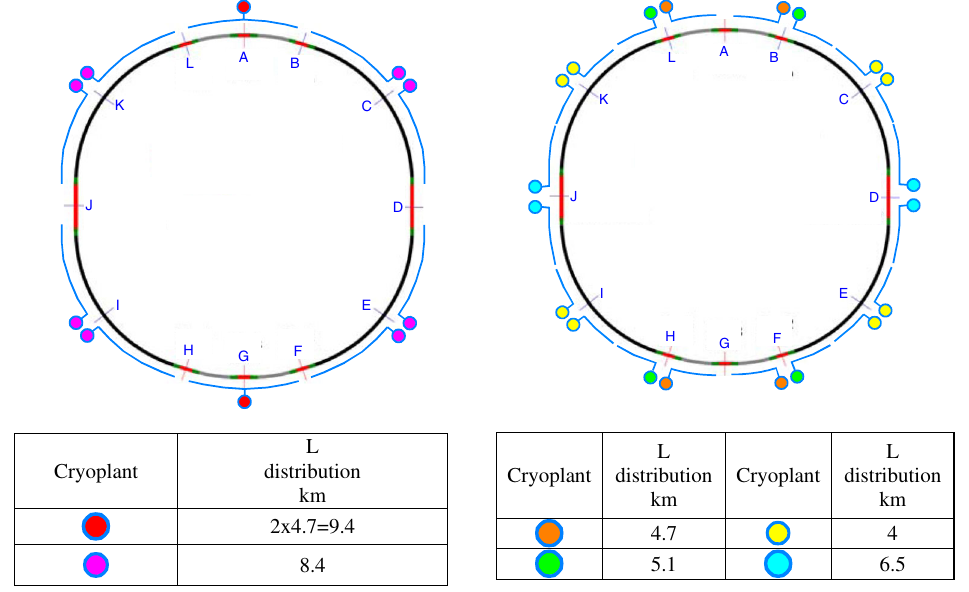
FIG. 1. Schematic diagram of the two proposed helium distribution networks for the FCC study